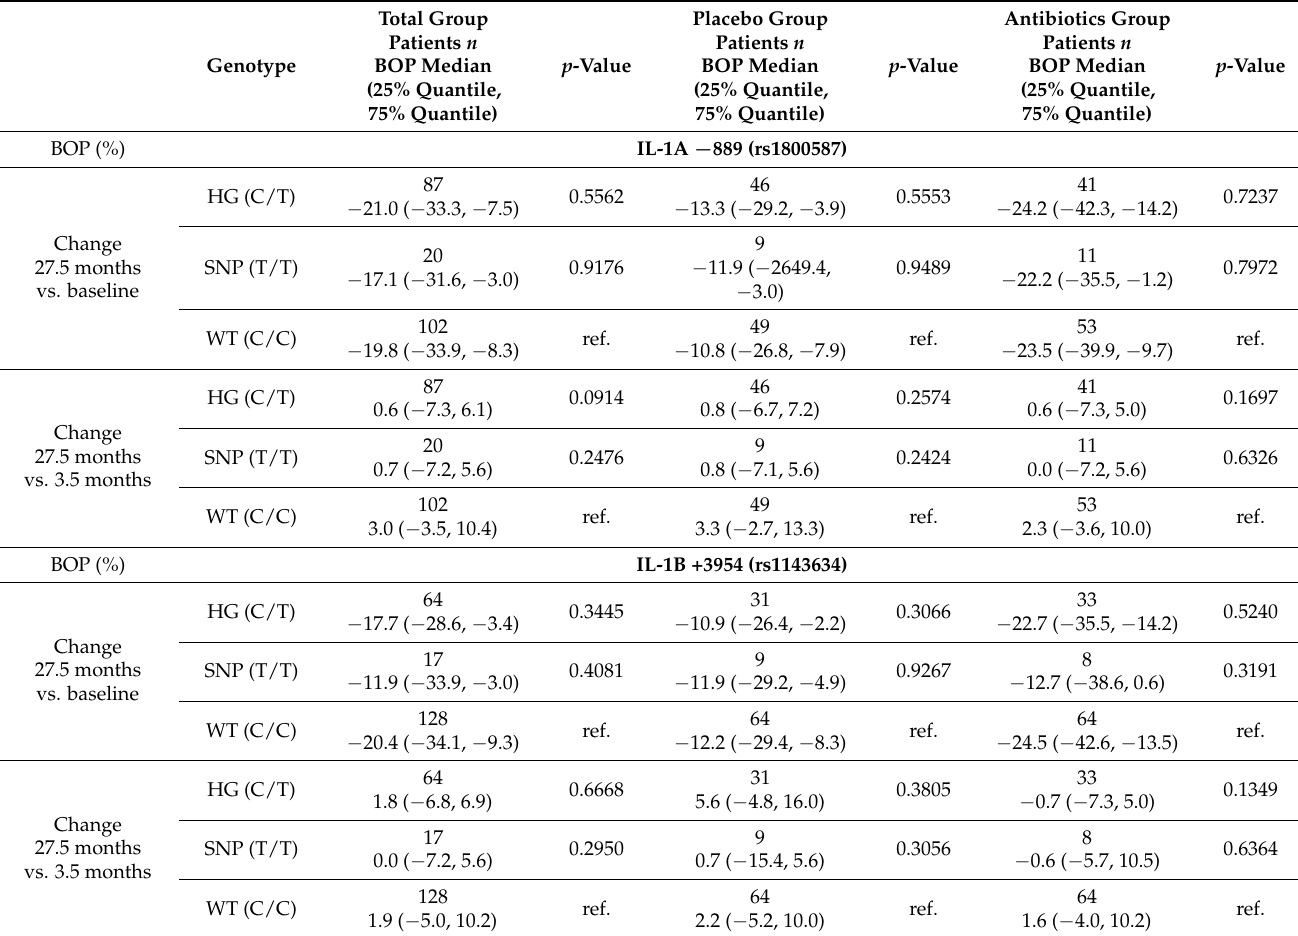
Table 4. Clinical measurements of the change of the bleeding on probing